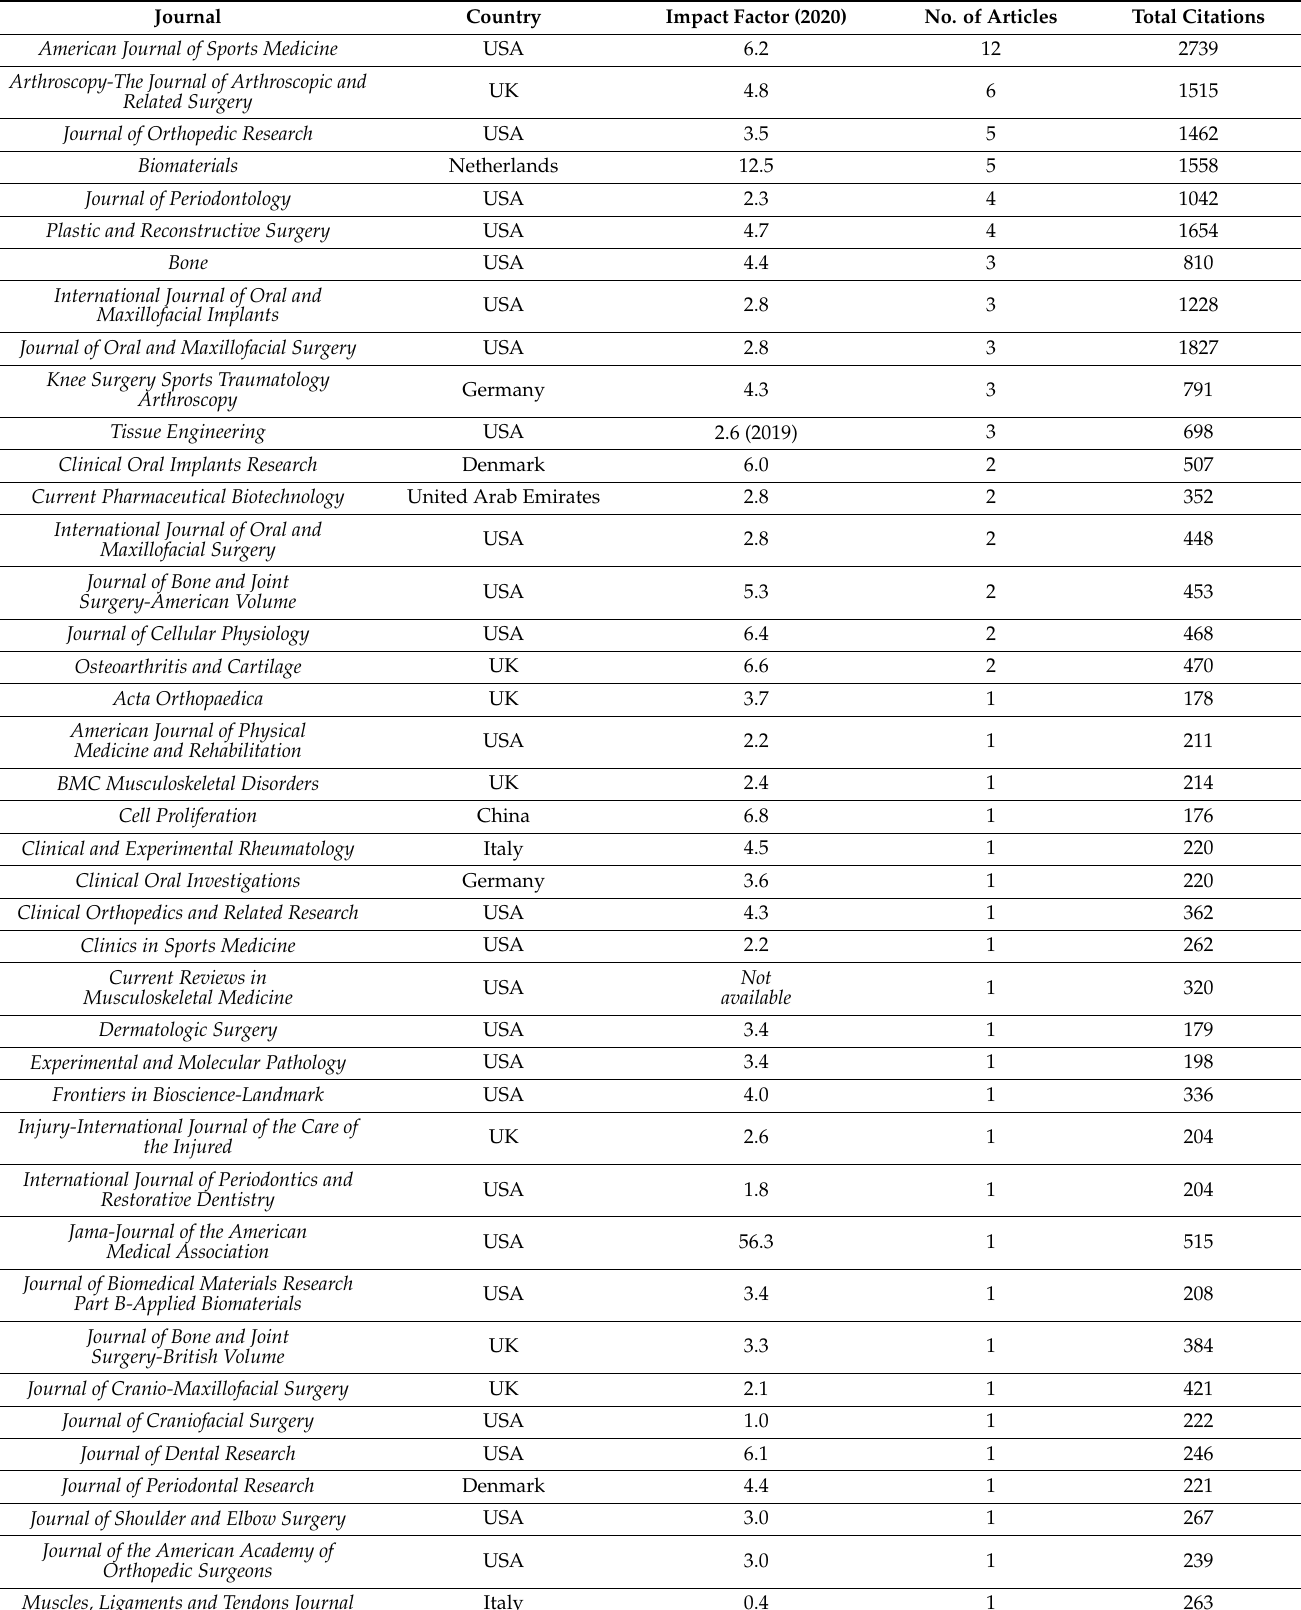
Table 3. Journals in which the top 100 most cited articles were